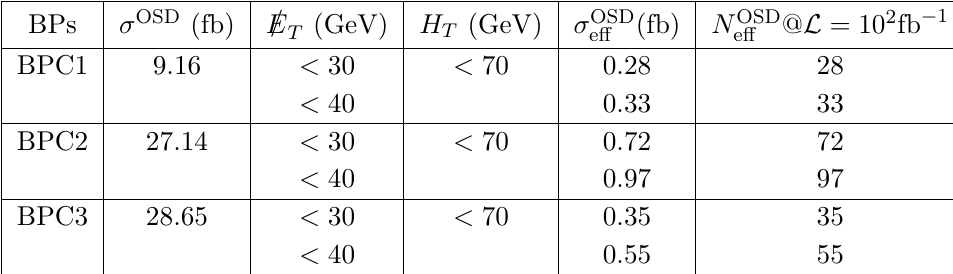
Table 6 . Signal cross-section for BPC1-BPC3 after the selection cuts are employed.